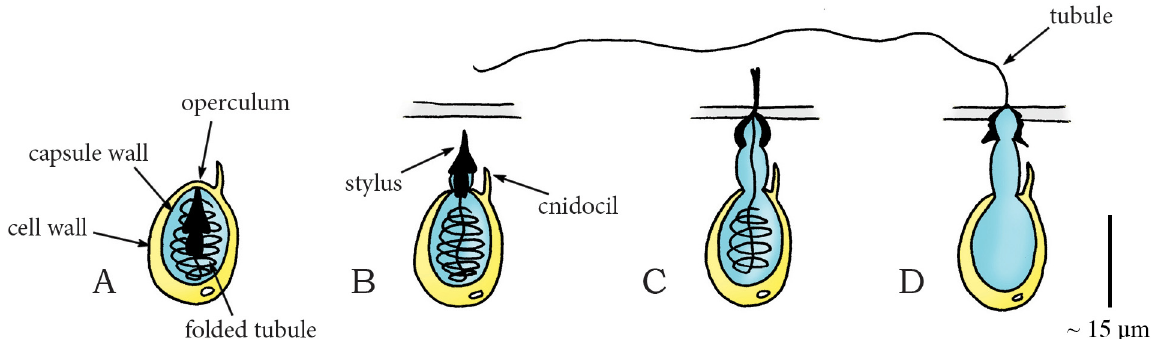
Fig 22. Osmotic-powered eversion catapult mechanism in the phylum Cnidaria. (A) The cnidocyte, consisting of a cell wall, capsule wall, folded tubule, and enclosed operculum. (B – C) After triggering the cnidocil, the operculum opens, and the shaft with stylus is discharged into the prey ’ s cuticle. (D) The cnidocyte with a totally everted tubule. Drawings based on schematic drawings and high-speed video images in [29]. Scale bar 15 μ